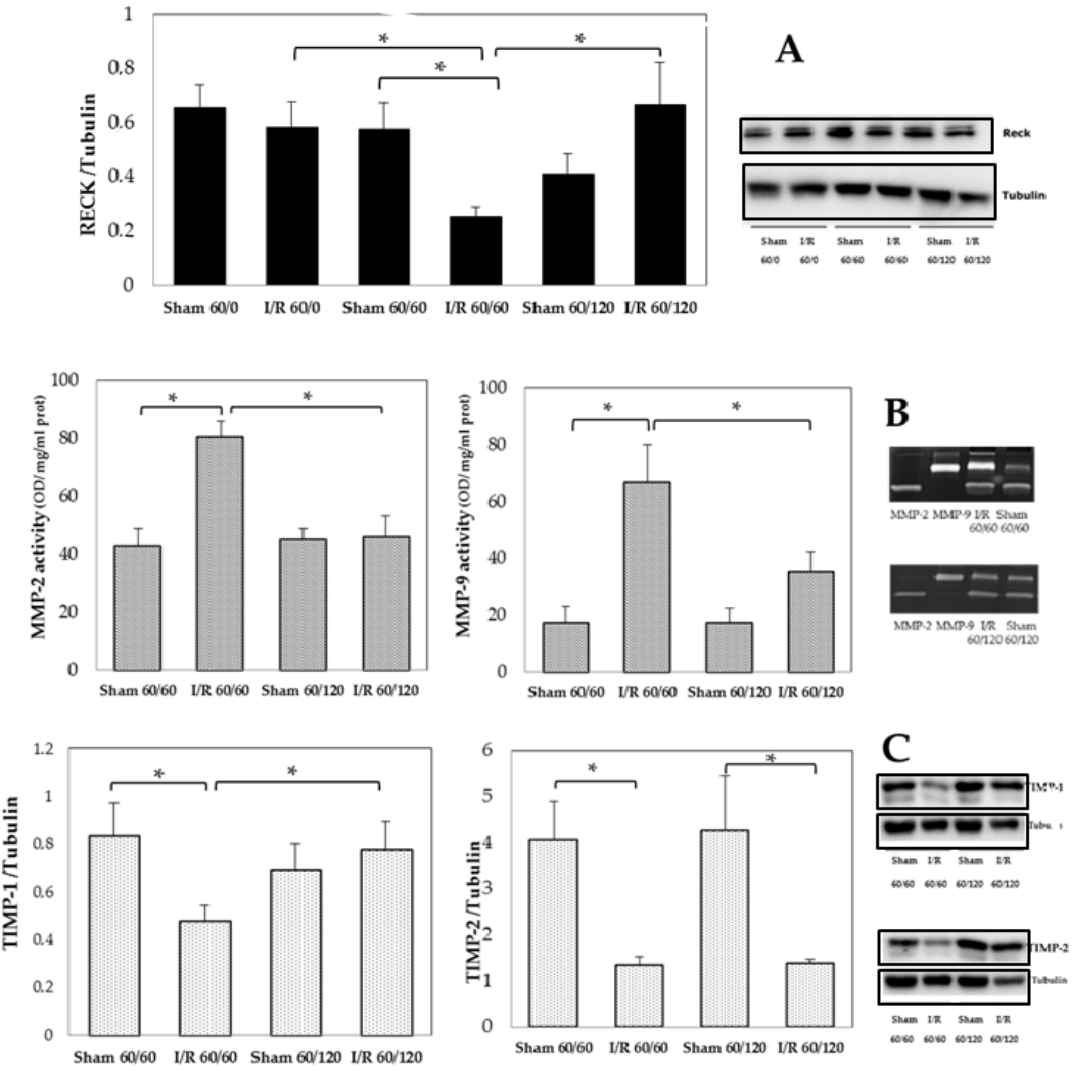
Figure 2. Hepatic MMP-2 and MMP-9 activity, RECK, TIMP-1, and TIMP-2 at the end of ischemia and after 60 min or 120 min of reperfusion. Panel ( A ): RECK, * p = 0.02; Panel ( B ): MMP-2, * p = 0.006; MMP-9: * p = 0.007; Panel ( C ): TIMP-1 * p = 0.04; TIMP-2, * p = 0.03. The results are reported as the mean ± SE of 6 different experiments. RECK, reversion-inducing cysteine-rich protein with Kazal motifs; TIMPs, tissue inhibitor of metalloproteinases.